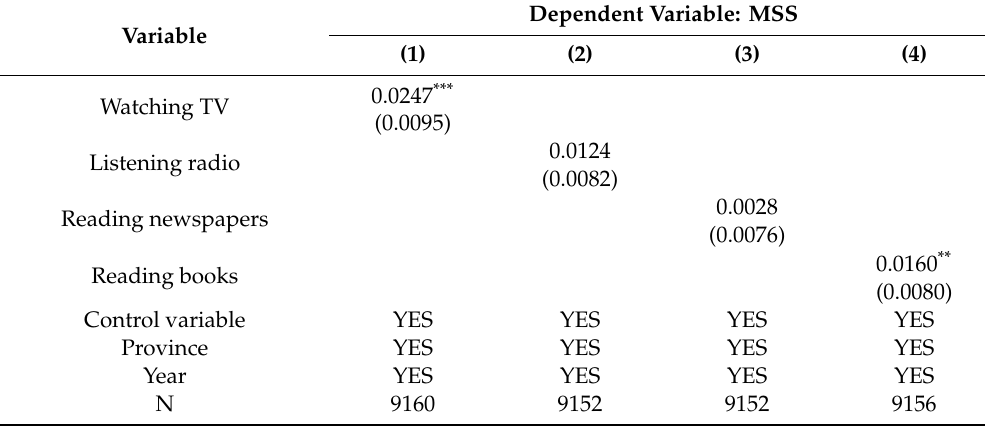
Table 10. Internet use and medical service satisfaction (placebo